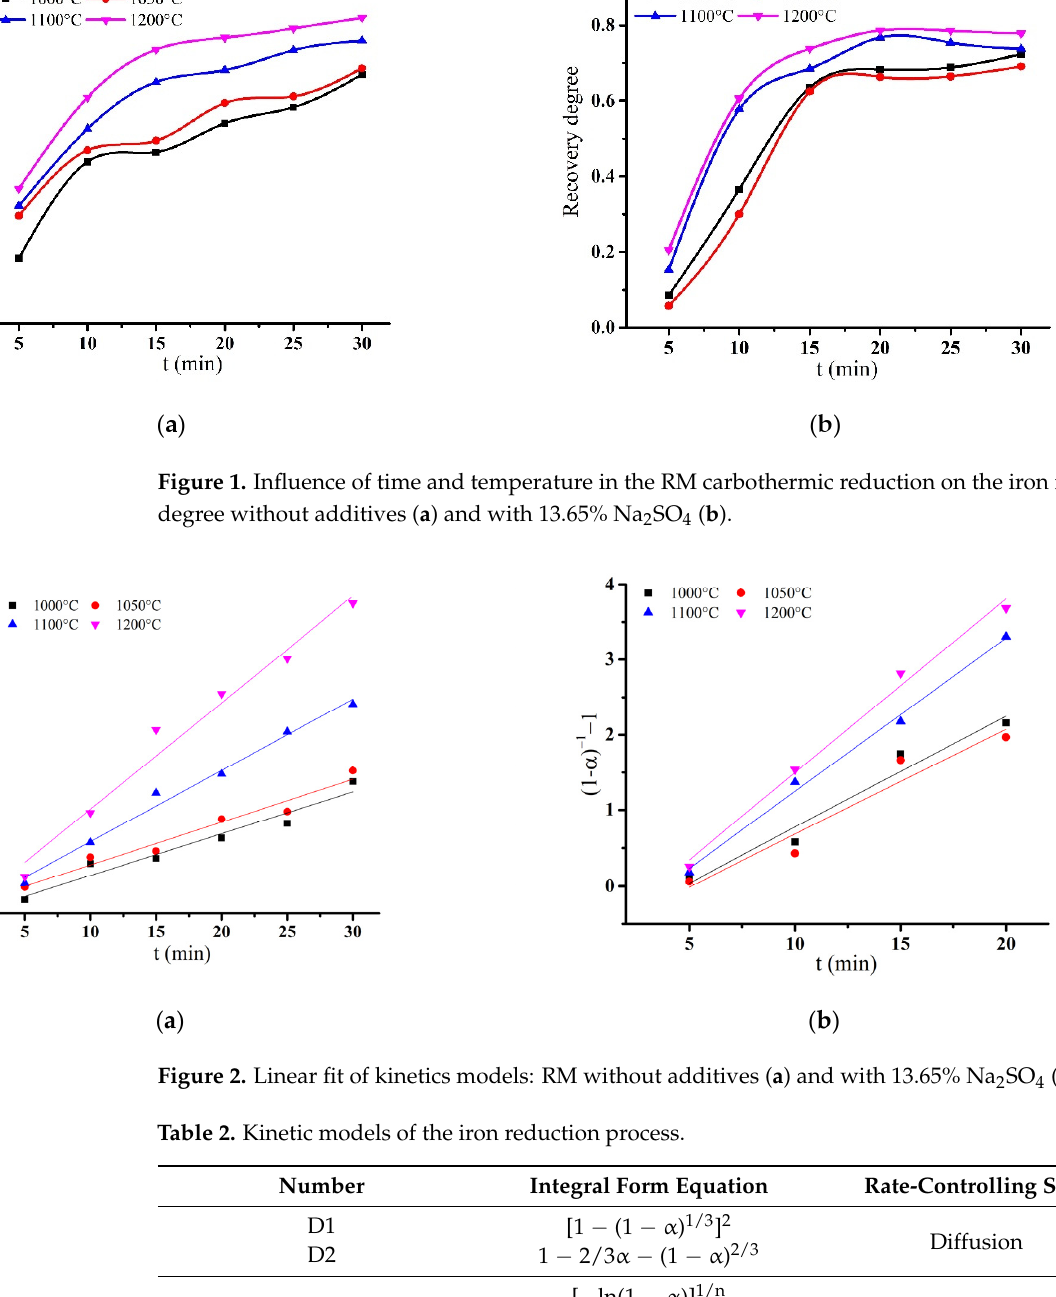
Table 3. Correlation coefficients for different kinetics models of the iron oxide reduction from RM with the Na 2 SO 4 additive and without.